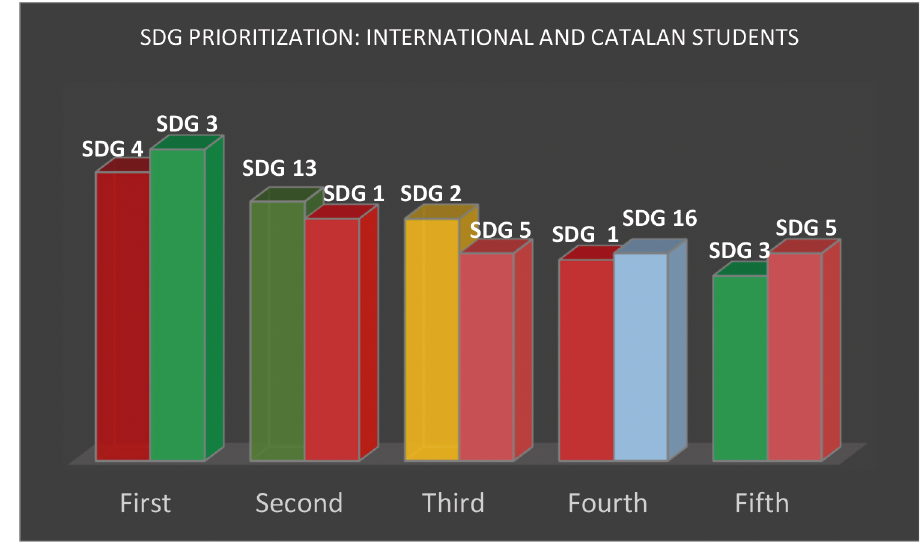
Figure 10. Priority given to the 5 SDGs selected by participating